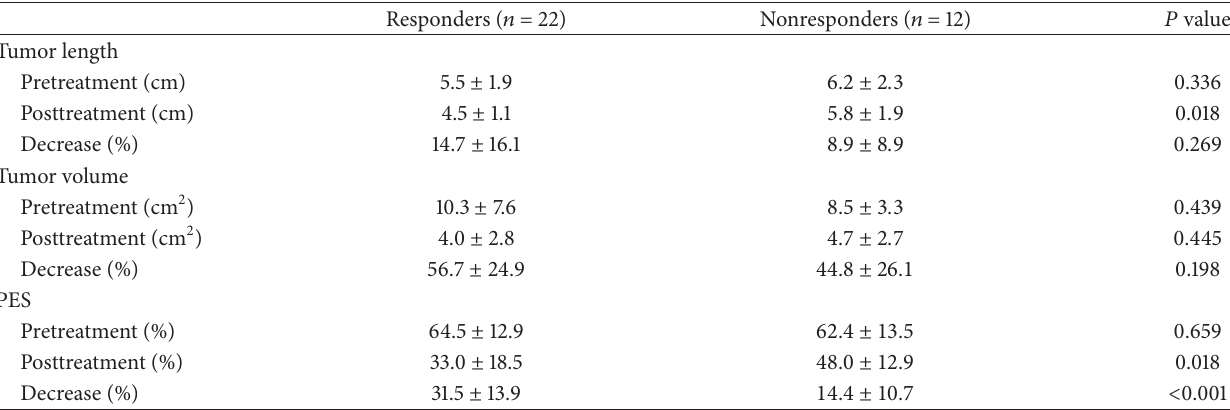
Figure 1: Measuring methods of esophageal stenosis. Table 2: Tumor length, volume, and